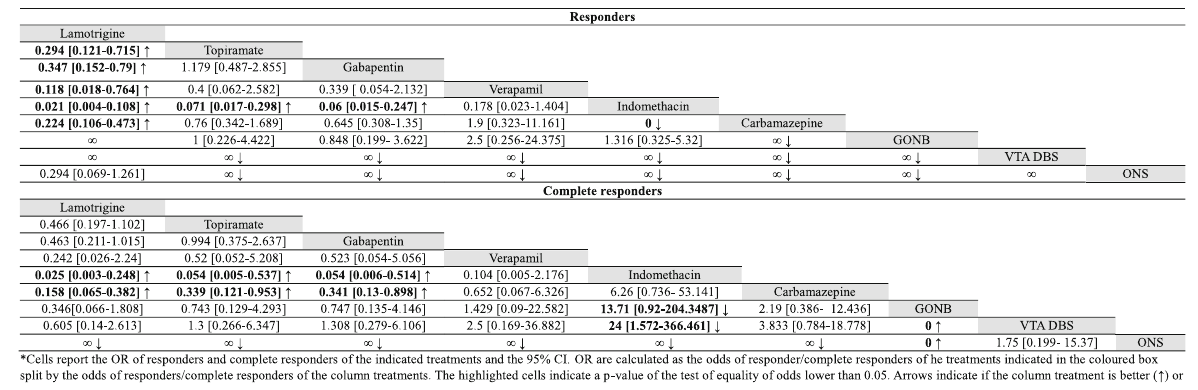
Table 7 statistical comparisons between the odds of responders and complete responders of prolonged treatments for SUNCT and